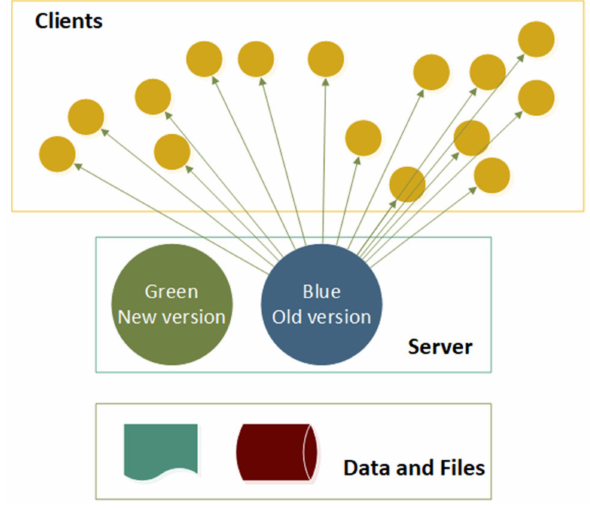
Figure 4. Blue/green